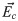
Clusters of cities and Power of Integration.In (a), three groups of cities show similar behavior in the number of communities detected and in their levels of integration. The length of the vectors represents the number of languages (communities) detected in each city; the color scale is representative of the decay of the entropy metric; the Power of Integration metric lead us to evaluate the potential of each city in uniformly integrating immigrant communities within its own urban area according to entropy values. In (b), decay of hl,c for the cities in each cluster. The points correspond to the values of the elements of Ec→ for each city placed in the x axis according to their index normalized to the total number of languages in c. The colors are for cities in the different clusters (C1 blue, C2 red and C3 green), and the lines are minimum square fits to the values of entropy ratios of each cluster.